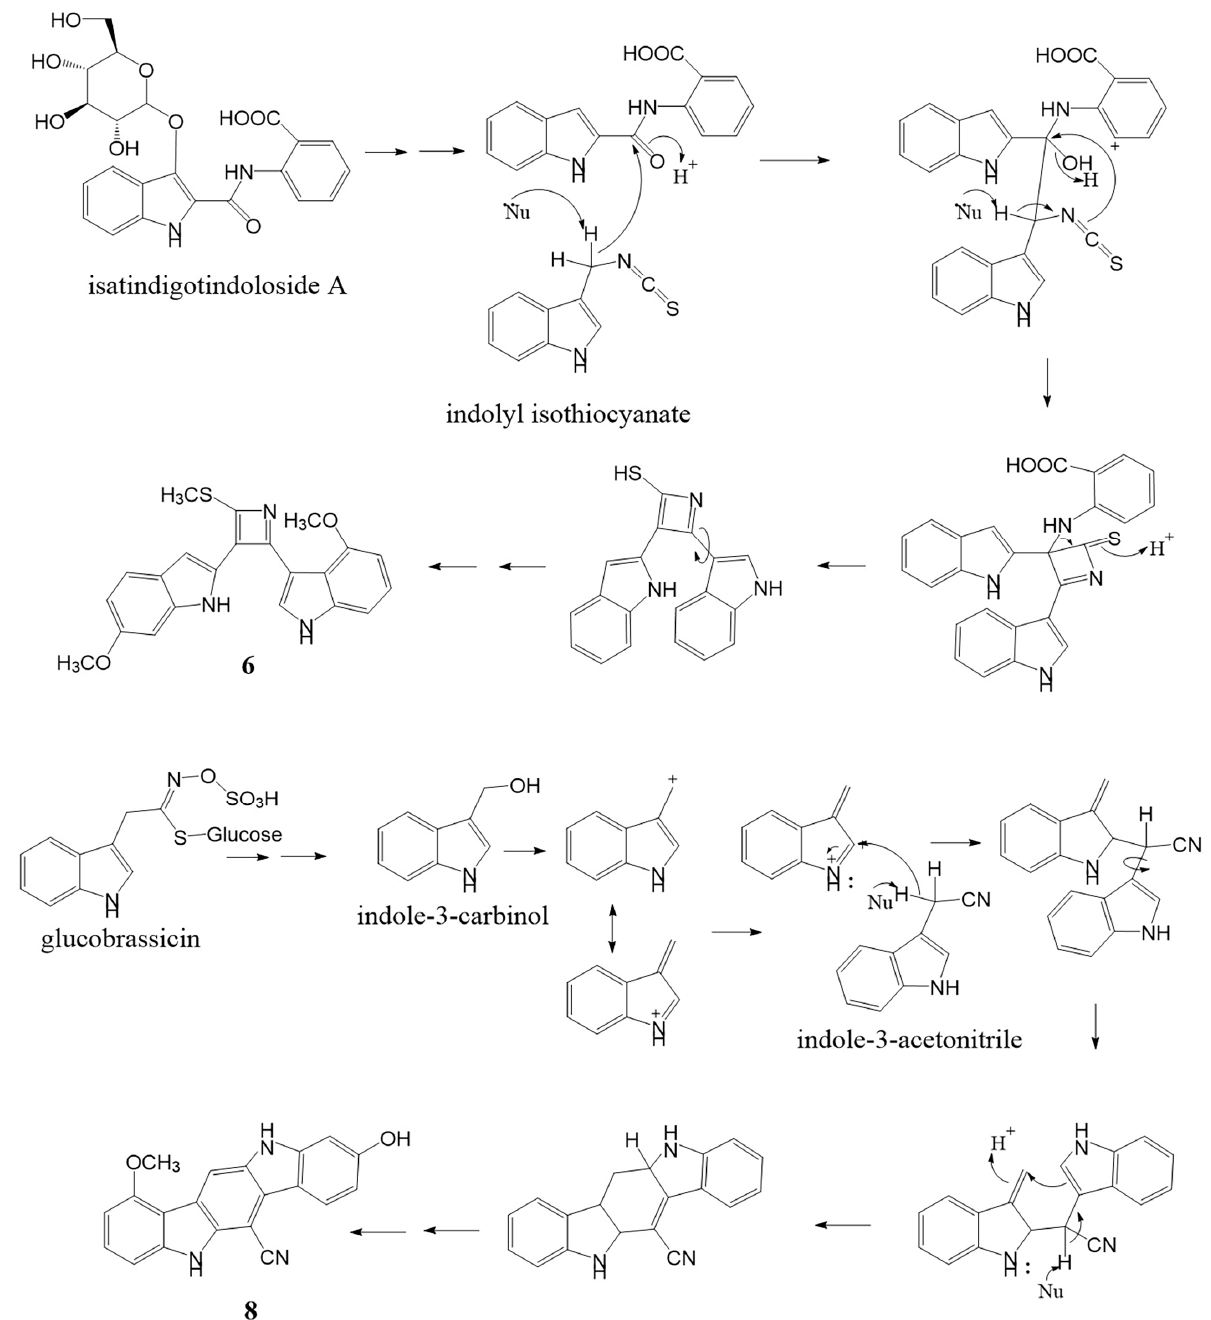
Figure 4. A proposed biosynthesis for 6 and 8 . Compound 8 was isolated as a dark green amorphous solid. Its molecular formula was established as C 20 H 13 N 3 O 2 (IHD 16) , based on the HR-ESI [M–H] − ion at m / z 326.0968 (calcd. for C 20 H 12 N 3 O 2 , 326.0935). The IR spectrum showed absorption bands due to hy- droxyl and amine NH (3359 cm − 1 ), nitrile (2212 cm − 1 ), and the aromatic ring (1632 and 1468 cm − 1 ). The 1 H-NMR data (Table 4) show signals of one 1,2,3-trisubstituted benzene ring